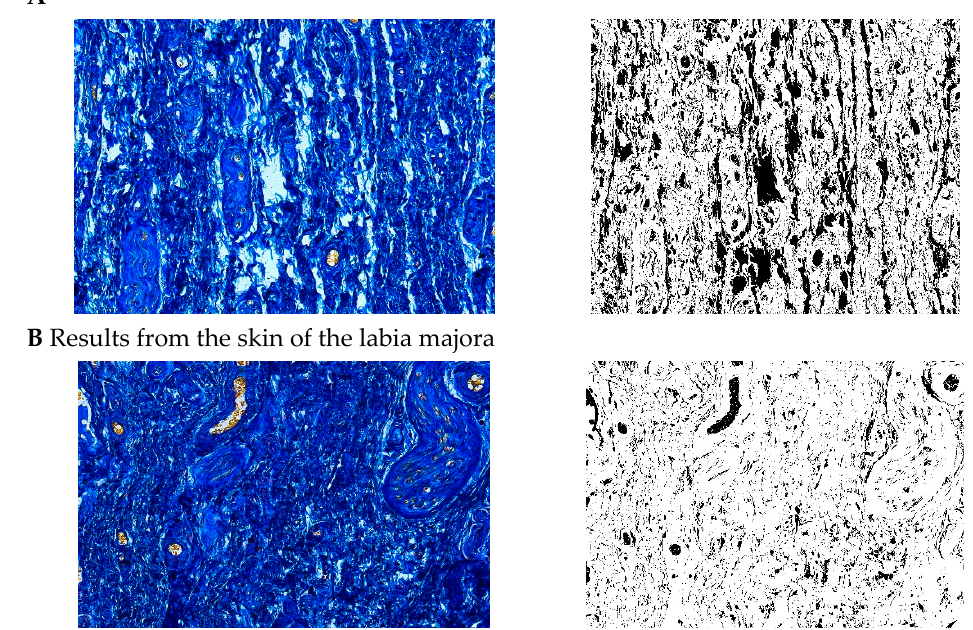
Figure 15. Segmentation before ( A ) and after ( B ) treatment (Mallory trichrome).